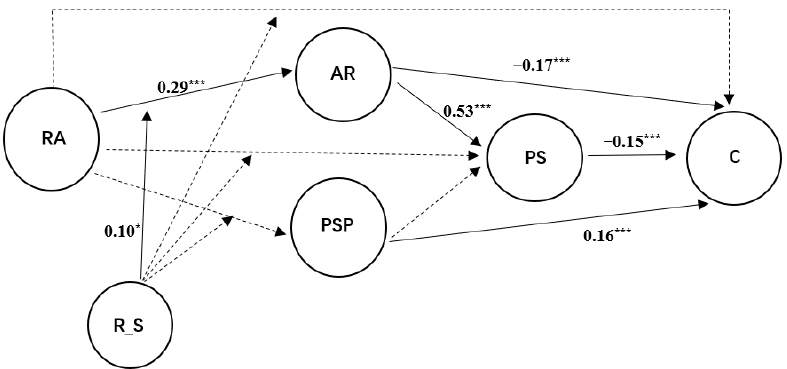
Figure 1. Standardized regression coefficients for the research model. RA = role ambiguity, R_S = relationship with supervisor, AR = affective rumination, PSP = problem-solving pondering, PS = perceived stress, C = creativity; *** p < 0.001, * p < 0.05. A dotted arrow indicates that the result is not significant. The paths between controlled variables and main variables in the models are not dis- played.